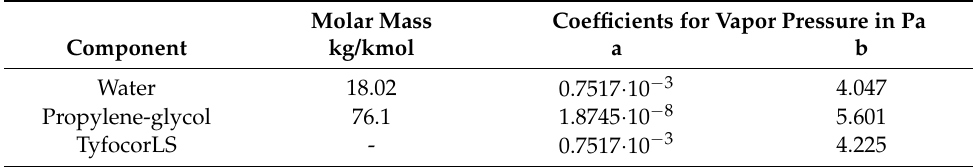
Table A4. Properties of water and propylene